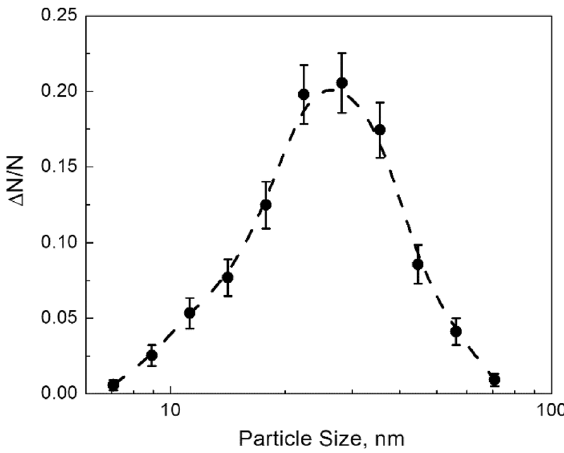
Figure 3. Size distribution of MgO nanoparticles collected from the negative flame. Error bars correspond to the possible errors in the number of particles contributing to given size intervals. The dashed line is a guide to the eye. The noticeable amount of the 10–15 nm size particles is